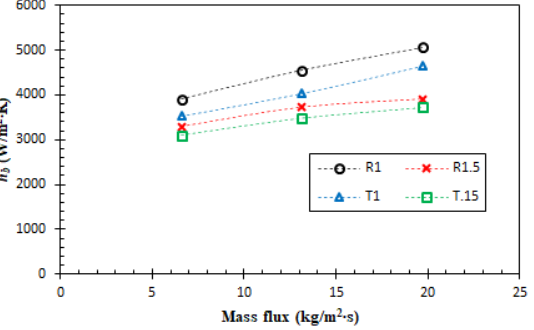
Figure 5. Average boiling heat transfer coefficient among four different surfaces.